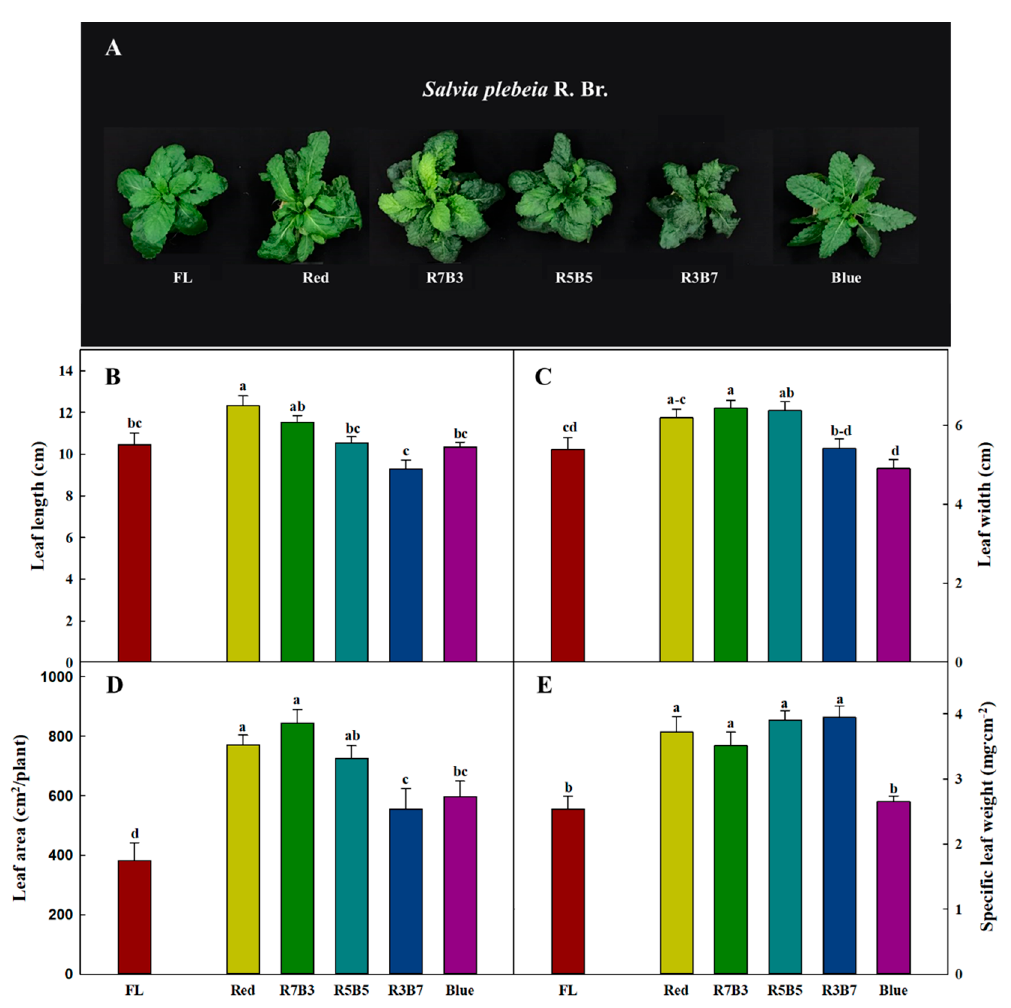
Figure 2. The growth ( A ), leaf length ( B ), leaf width ( C ), leaf area ( D ), and specific leaf weight ( E ) of Salvia plebeia R. Br. as a ff ected by di ff erent light treatments at 35 days after transplanting. Vertical bars Salvia plebeia R. Br. as affected by different light treatments at 35 days after transplanting. Vertical bars represent the standard deviation from the mean ( n = 3). Di ff erent letters in the same column indicate represent the standard deviation from the mean ( n = 3). Different letters in the same column indicate significant di ff erences based on Tukey’s multiple range test ( α ≤ significant differences based on Tukey’s multiple range test ( α ≤ 0.05).